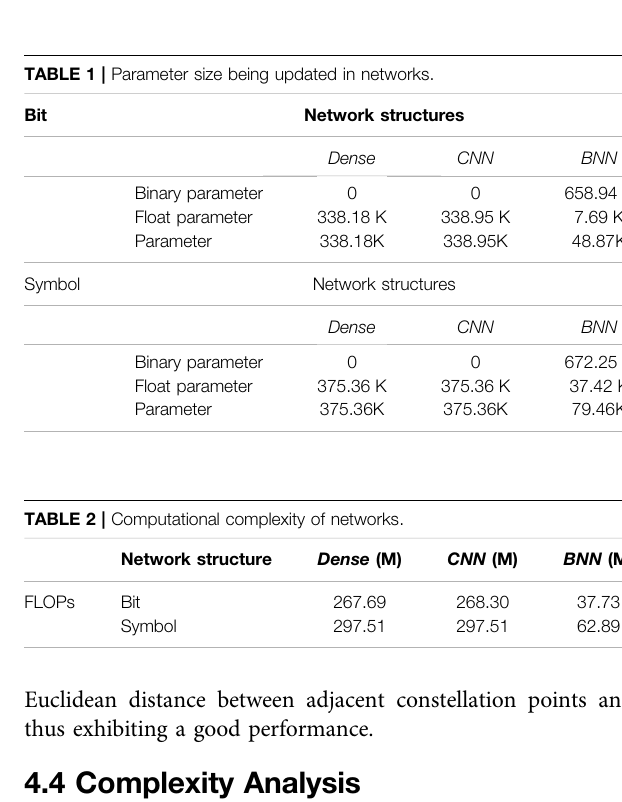
FIGURE 11 | Comparison of constellations under different BNN structures based on ReActNet.